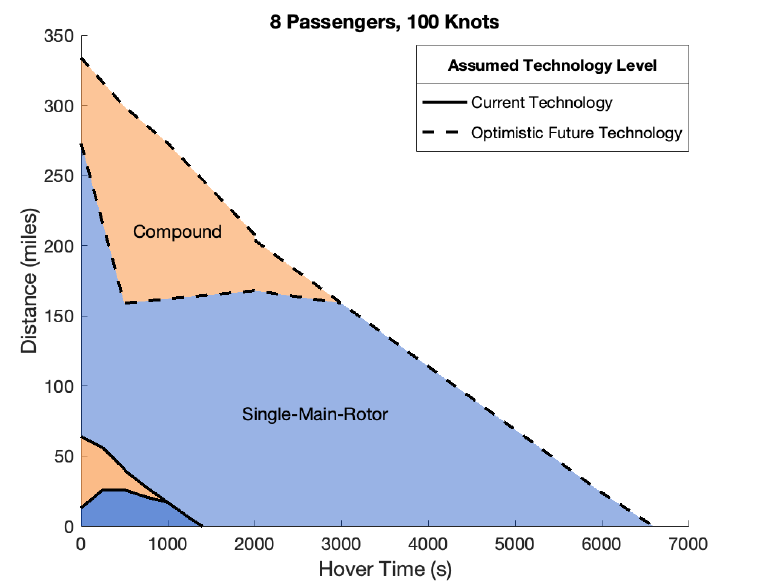
Figure 10. Feasible design space with most efficient options for a 8-passenger payload and 100 knot cruise speed assuming a decoupled drive-train.